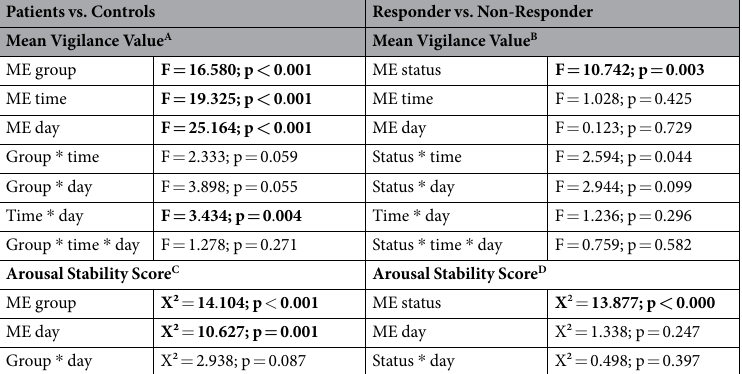
Patients vs. Controls